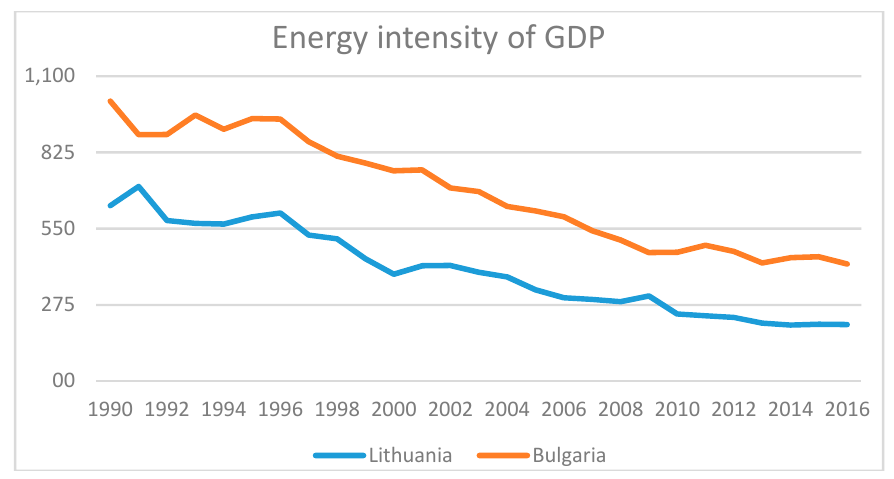
Figure 8. Primary energy intensity of GDP in Bulgaria and Lithuania, toe/M€'10. Source: [39,40].